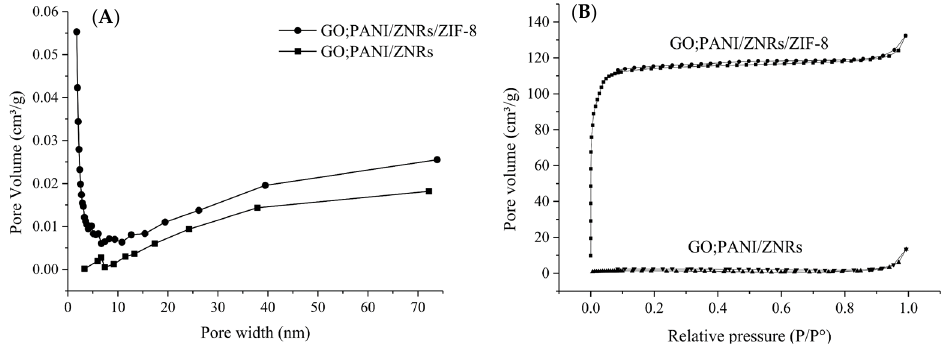
Figure 5. ( A ) Pore width distribution of GO:PANI/ZNRs and GO:PANI/ZNRs/ZIF − 8 and ( B ) N 2 adsorption-desorption isotherms of GO:PANI/ZNRs and GO:PANI/ ZNRs/ZIF −